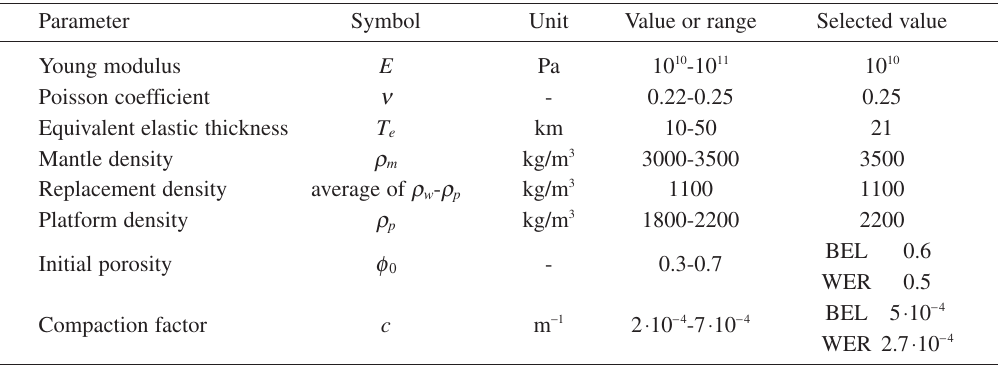
Table I. List of parameters, their symbols and values used during numerical modelling. The values in the last column are those selected for the model application to the Late Anisian-Early Ladinian carbonate platforms of the Dolomites, Northern Italy. The selected values for the initial porosity and the compaction factor refer to the Bellerophon Formation (BEL) and the Werfen Formation (WER), respectively.